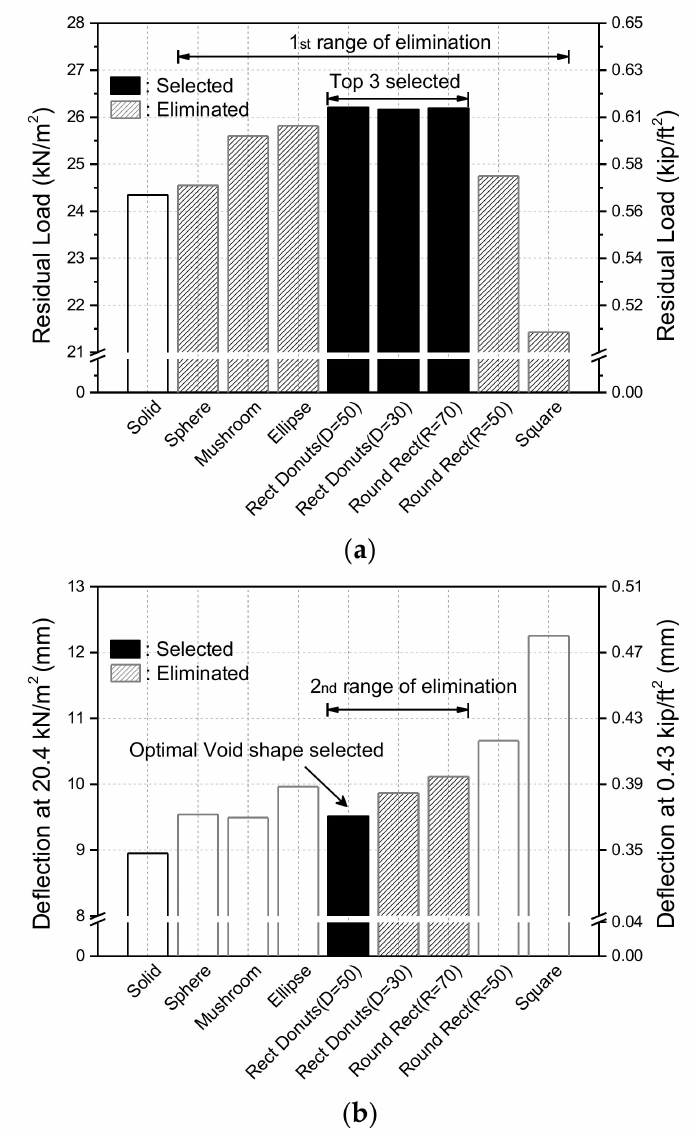
Figure 6. Determination of the optimal void shape. ( a ) by the load-bearing capacity (1st try); ( b ) by the load-bearing capacity (2nd